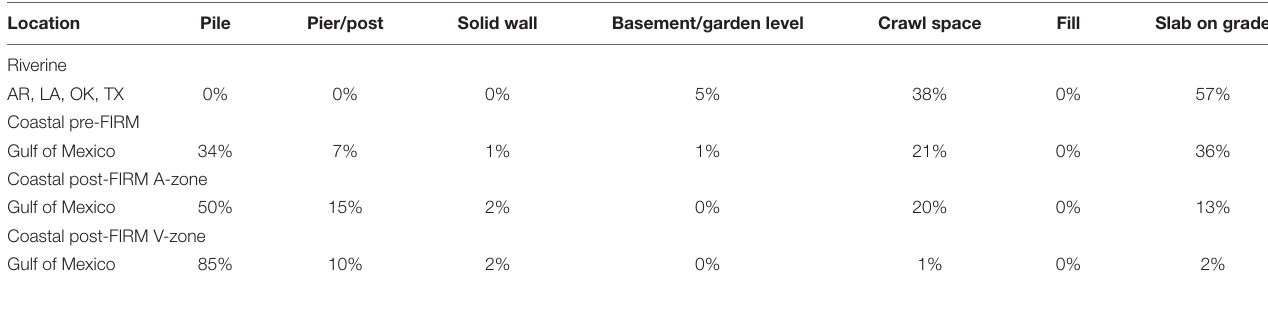
TABLE 2 | Distribution of foundation type for sampled residential homes in Louisiana (FEMA, 2015).